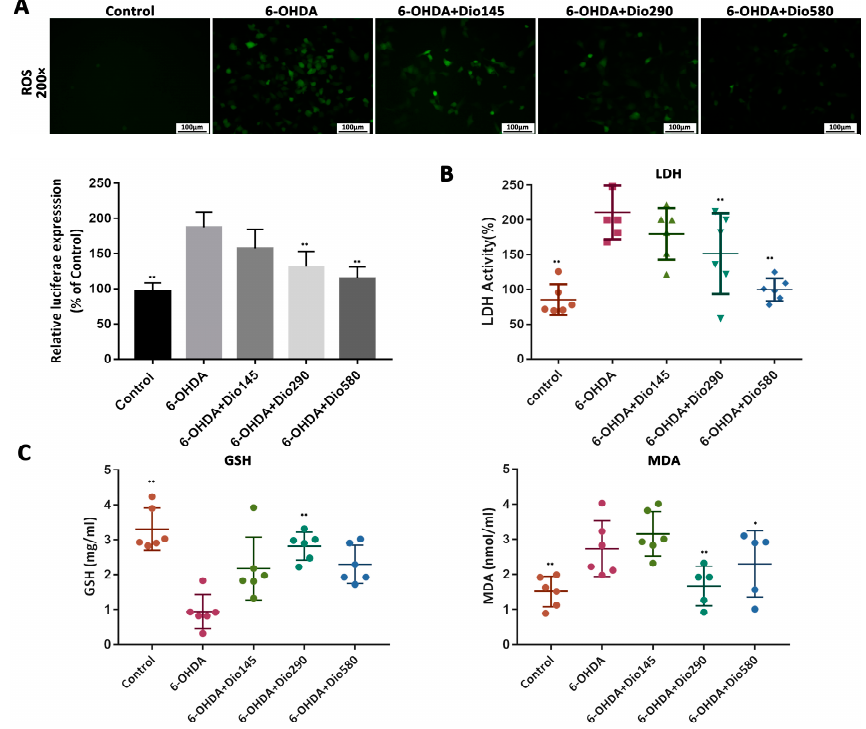
Figure 3. Dioscin normalized 6-hydroxydopamine (6-OHDA)-induced oxidative damage in PC12 cells. ( A ) Effects of dioscin on intracellular ROS level in PC12 cells ( × 200 magnification). ( B , C ) The levels of LDH, MDA and GSH in PC12 cells. Data are expressed as mean ± SD ( n = 6). ** p < 0.01 and * p < 0.05 compared with the 6-OHDA